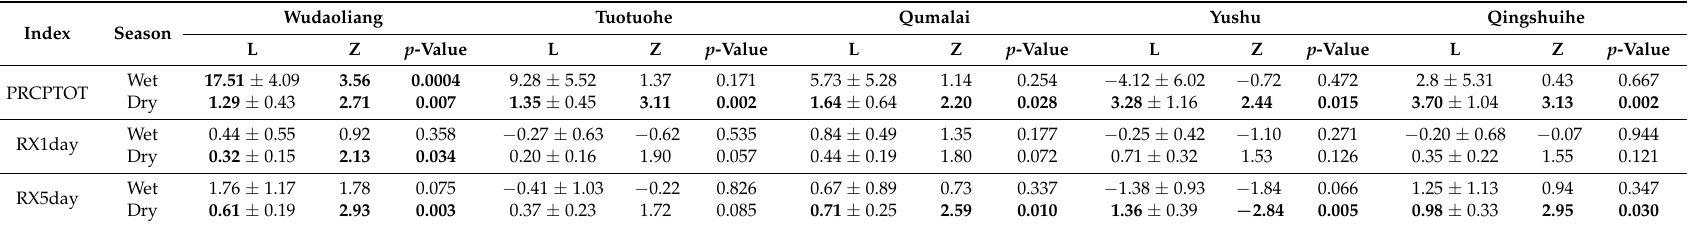
Table 6. Linear trends and results of the Mann–Kendall (MK) test for the seasonal indices (PRCPTOT, RX1day, and RX5day) over the SRYR during